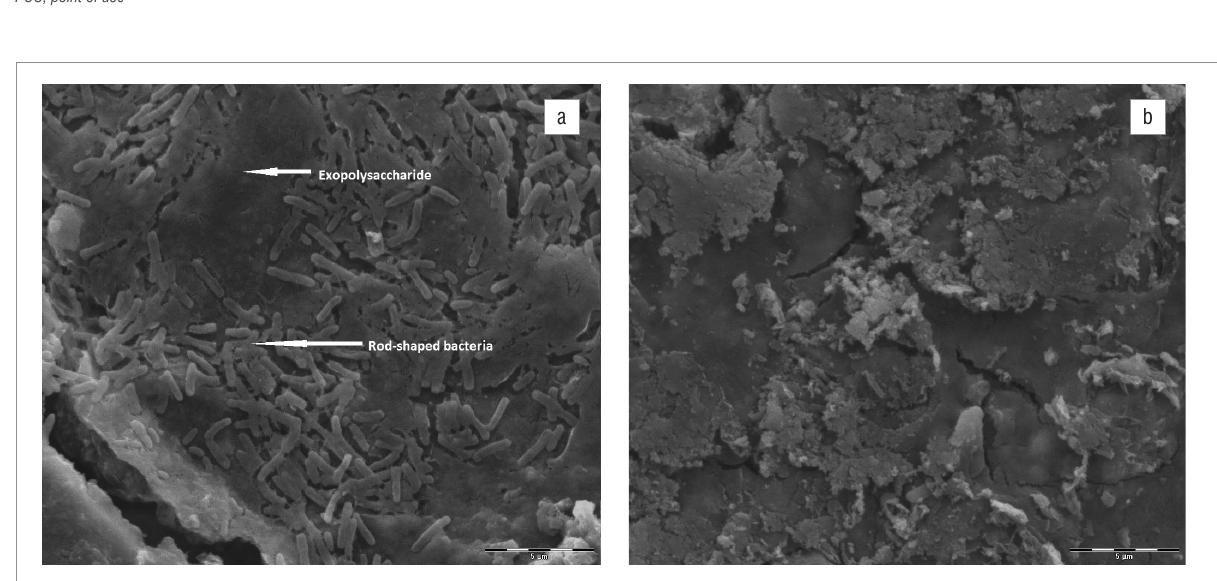
Figure 3: Electron micrographs of biofilm from Modimola Dam collected using (a) galvanised coupons or (b) copper coupons.